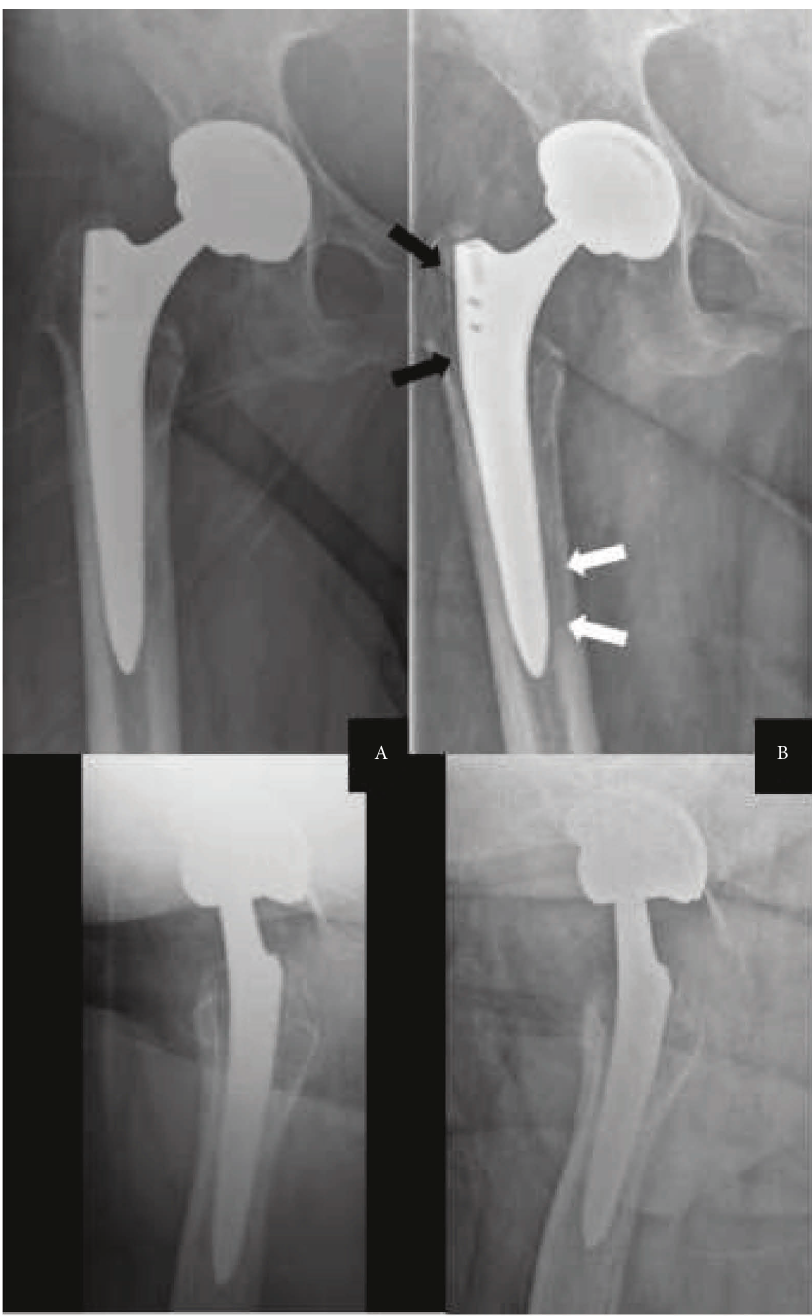
Figure 2: Anteroposterior and axial radiographs of the right hip of Case Two, 6 years after revision THA (a) Despite a newly diagnosed S. lugdunensis PJI, components show no signs of loosening. At the 10 years mark (b) after 4 years of documented, untreated PJI, the radiolucent line observable frequently in Gruen zone 1 with this type of stem (black arrows) remains stable. There is also some evidence of diaphyseal, endocortical osteolysis (white arrows), but no subsidence of the stem, and endosteal ossification at the tip of the stem remains stable. The cup is well fixed. In an asymptomatic patient, this implant can be considered sufficiently integrated. Note the poor contrast, particularly on the axial views in the lower row, due to morbid obesity (BMI of 48kg/m 2